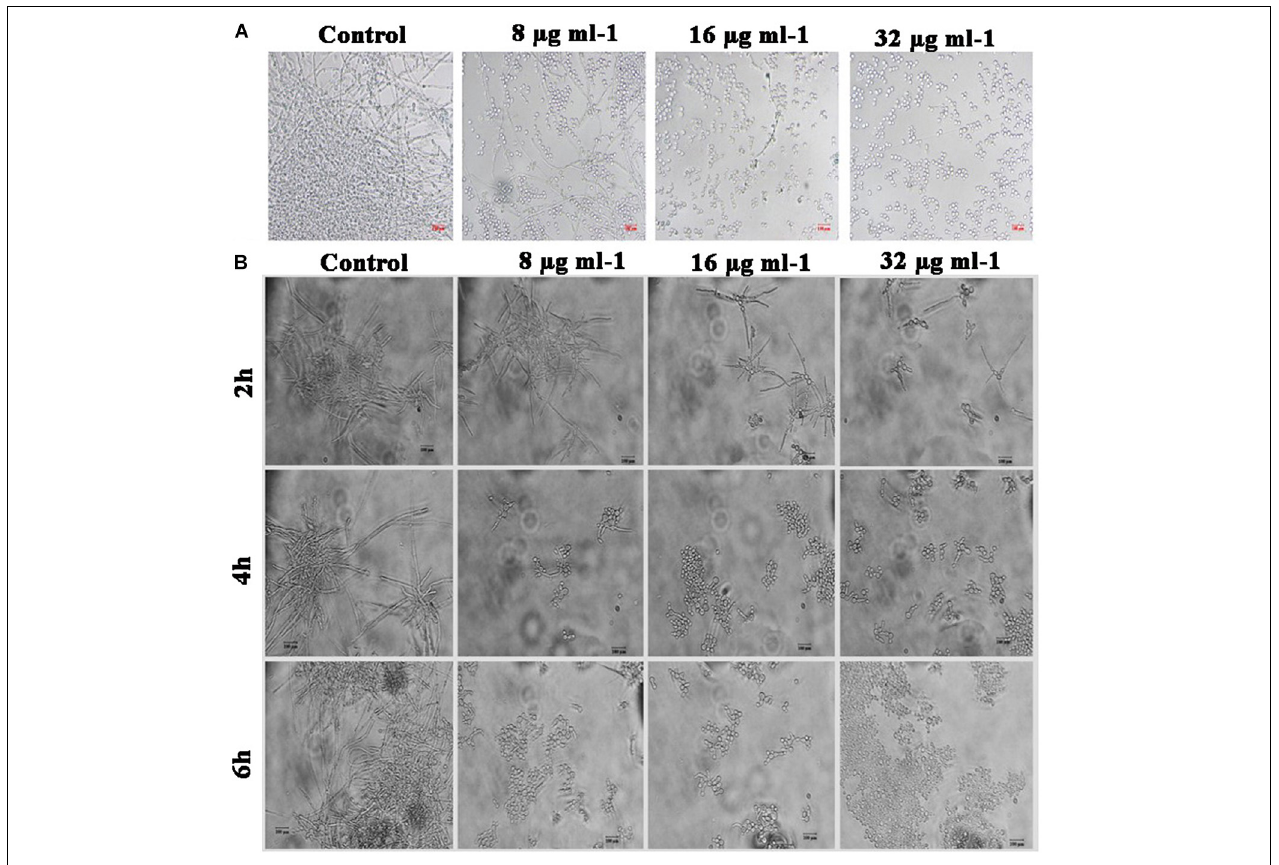
FIGURE 5 | Effect of piperine on phenotypic switching. (A) Control in the morphological transition from yeast to hyphal form. (B) Transition of preformed hyphal cells to yeast forms in time course (2, 4, and 6